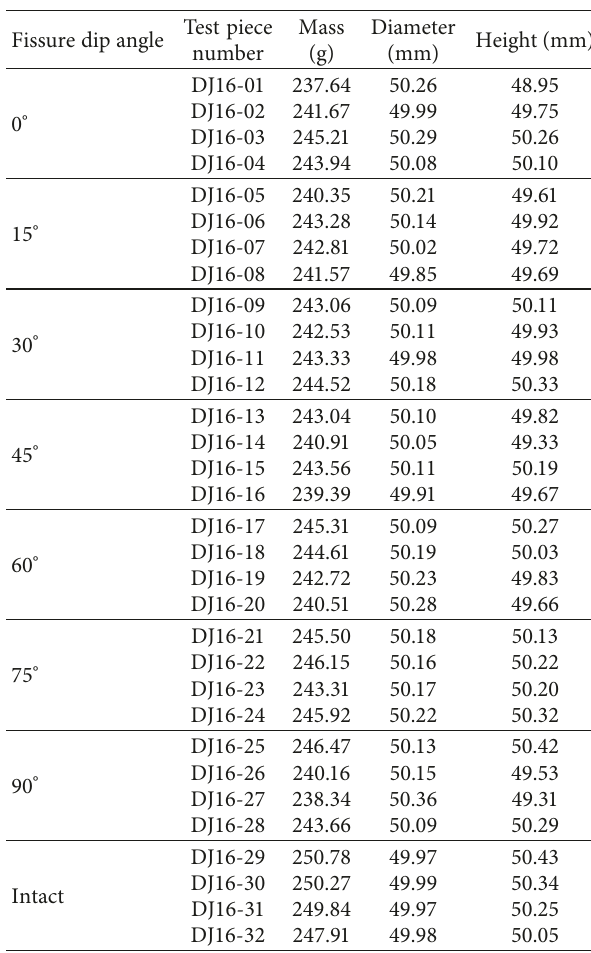
Figure 2: Prepared specimens. Table 1: Basic physical parameters of rock